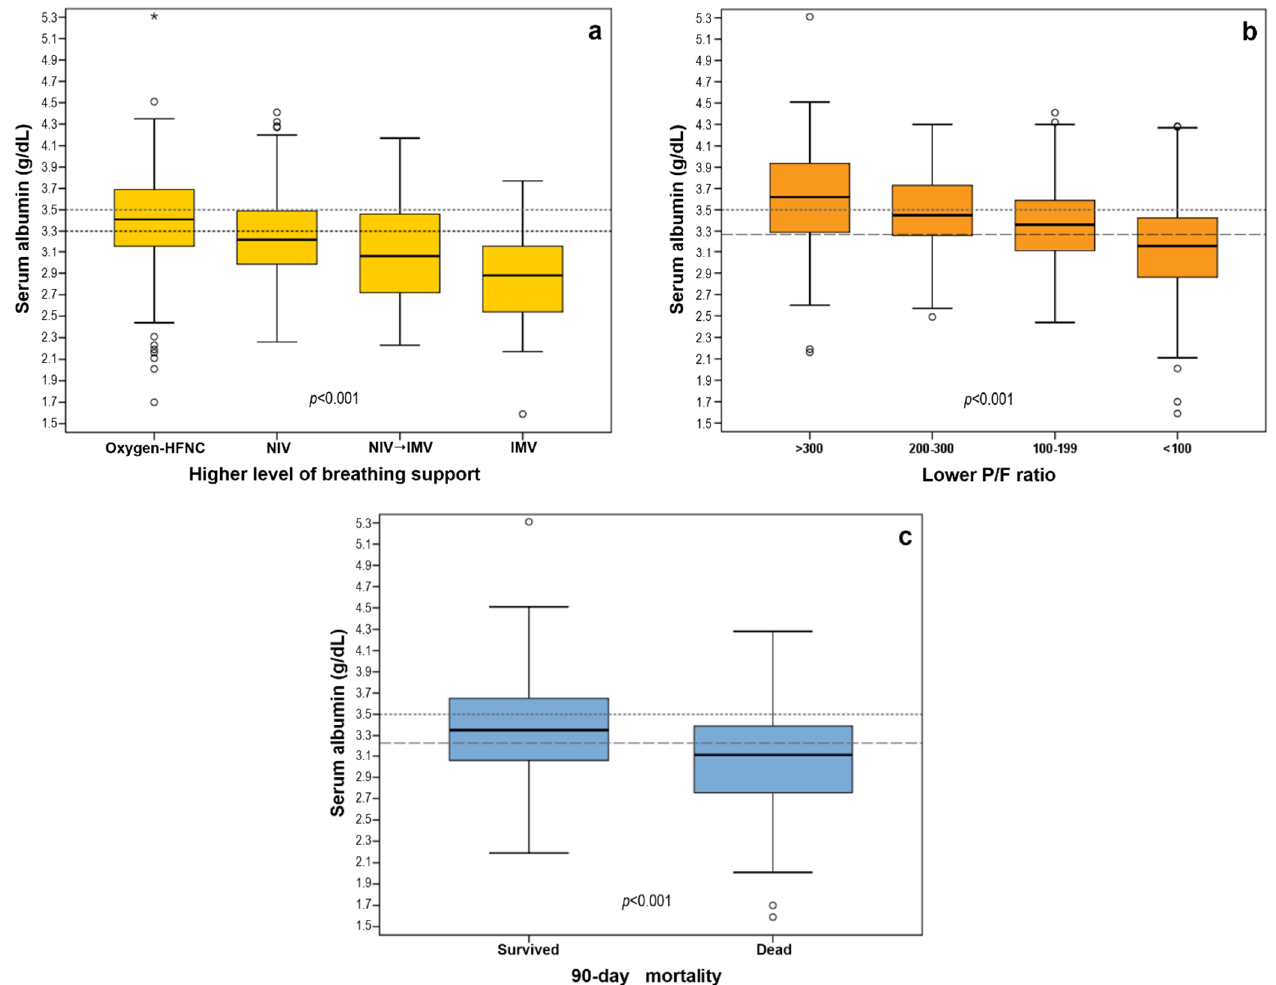
Figure 1. Differences among study subgroups according to serum albumin level at hospital admission: ( a ) higher level of breathing support; ( b ) lower P/F ratio; and ( c ) 90-day mortality. Black horizontal line inside the boxes: median. Boxes height: IQR. Whiskers: 1.5 × IQR. Small circles: outliers. Stars: extreme values. Small-dashed lines: serum albumin laboratory normal threshold. Large-dashed lines: serum albumin best cutoff values. HFNC: high-flow nasal cannulae. NIV: non-invasive mechanical ventilation. IMV: invasive mechanical ventilation.